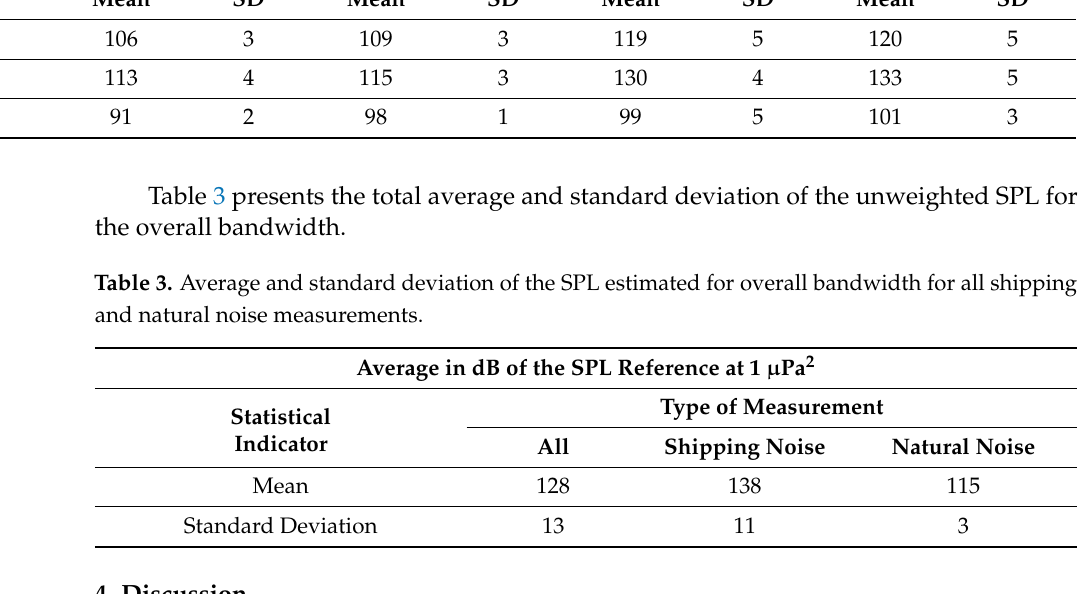
Figure 14. Annual average of the three groups of measurements according to the identification of the acoustic sources of the mean value of SPL for the overall bandwidth.